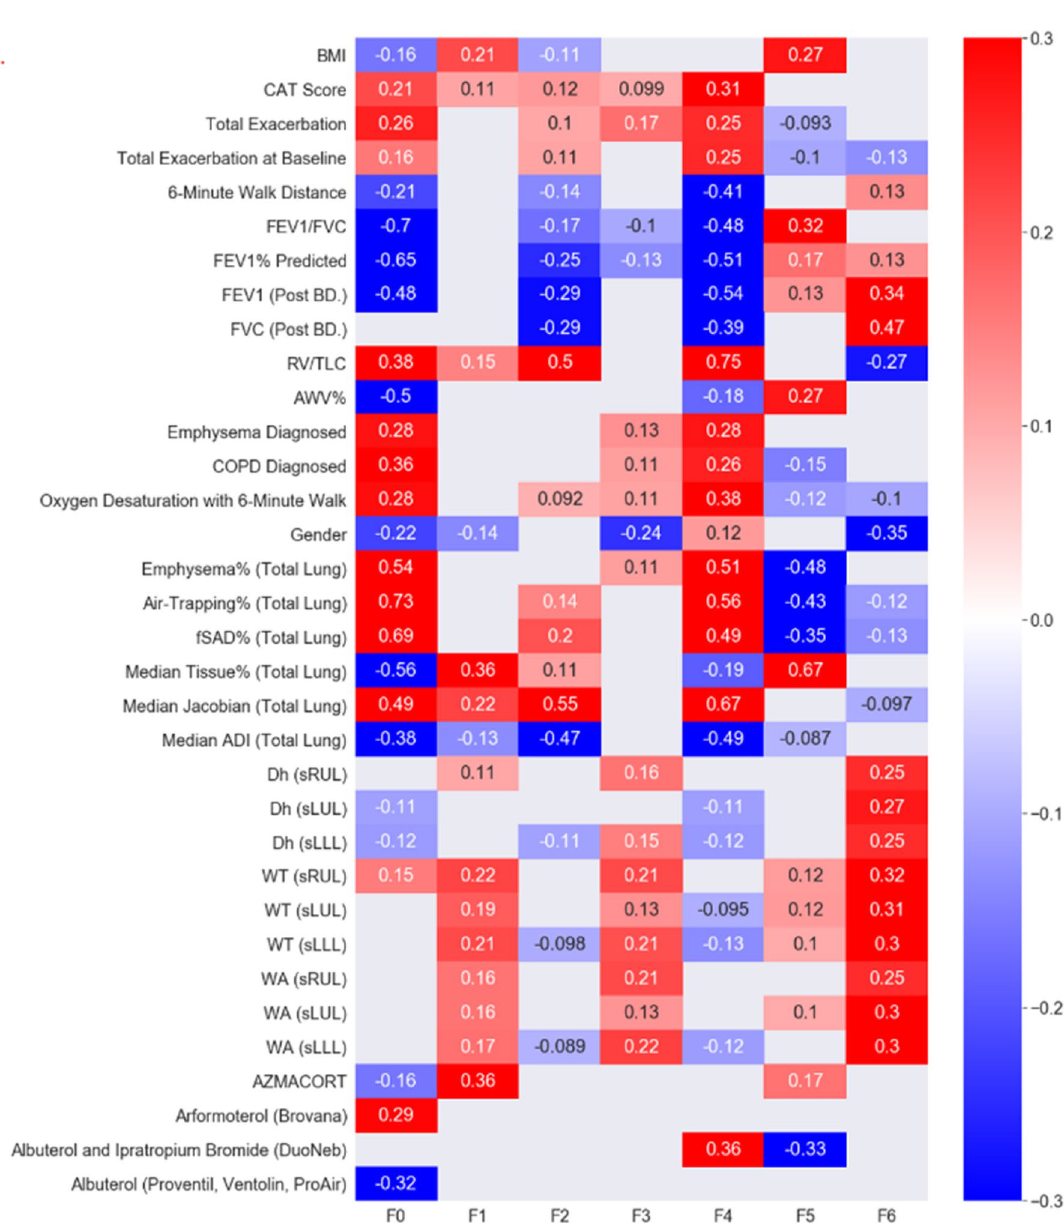
Figure 5. Correlations between each of the seven factors and related clinical data, imaging-based variables, and use of drugs. Only correlations with p value less than 0.05 are shown in the